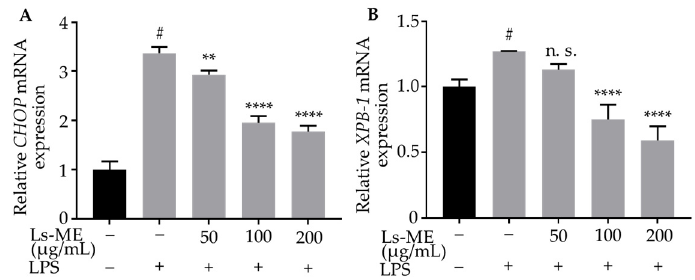
Figure 6. Ls-ME suppressed the expression of CHOP ( A ) and XBP-1 ( B ) in LPS-stimulated RAW 264.7 cells. Cells were cultured with serial concentrations of Ls-ME for 24 h, followed by treatment with LPS (1 µg/mL) for 18 h. The mRNA levels of CHOP , XBP-1 were analyzed using RT-qPCR. Data of the three replicates are represented as mean ± SD. # p < 0.05 is expressed in comparison with cells incubated alone; ** p < 0.01; **** p < 0.0001 are expressed in comparison with LPS treatment only; n. s., not significant.